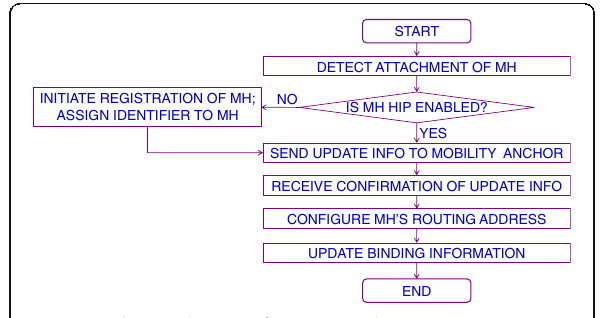
Fig. 3 Attachment detection for an HIP and a non-HIP